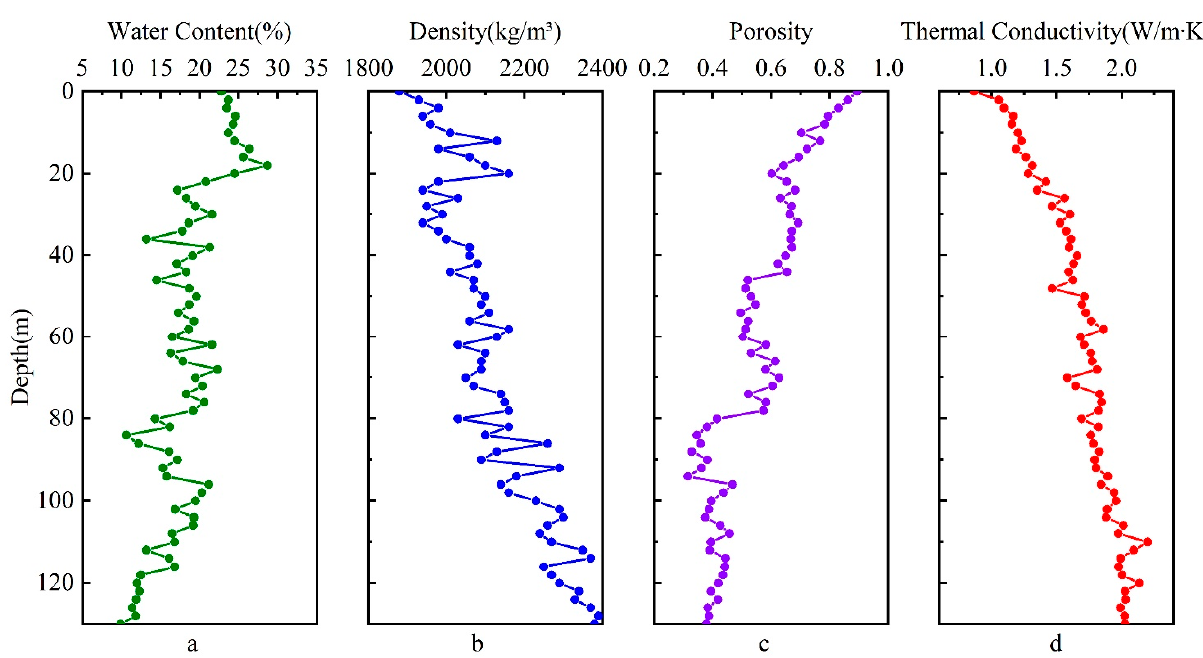
Figure 4. Laboratory test results. ( a ) Water content. ( b ) Density. ( c ) Porosity. ( d ) Thermal conductivity.